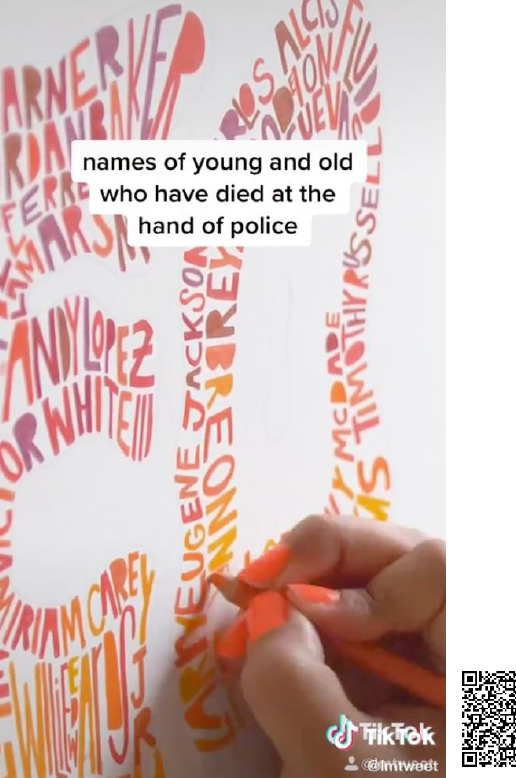
Figure 4. @lmtweet Leila Mae Thompson with her work-in-progress video.